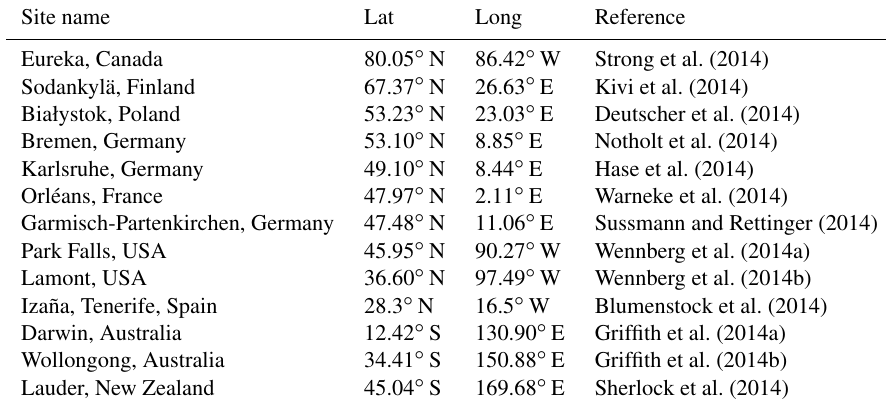
Table 2. TCCON sites used in this